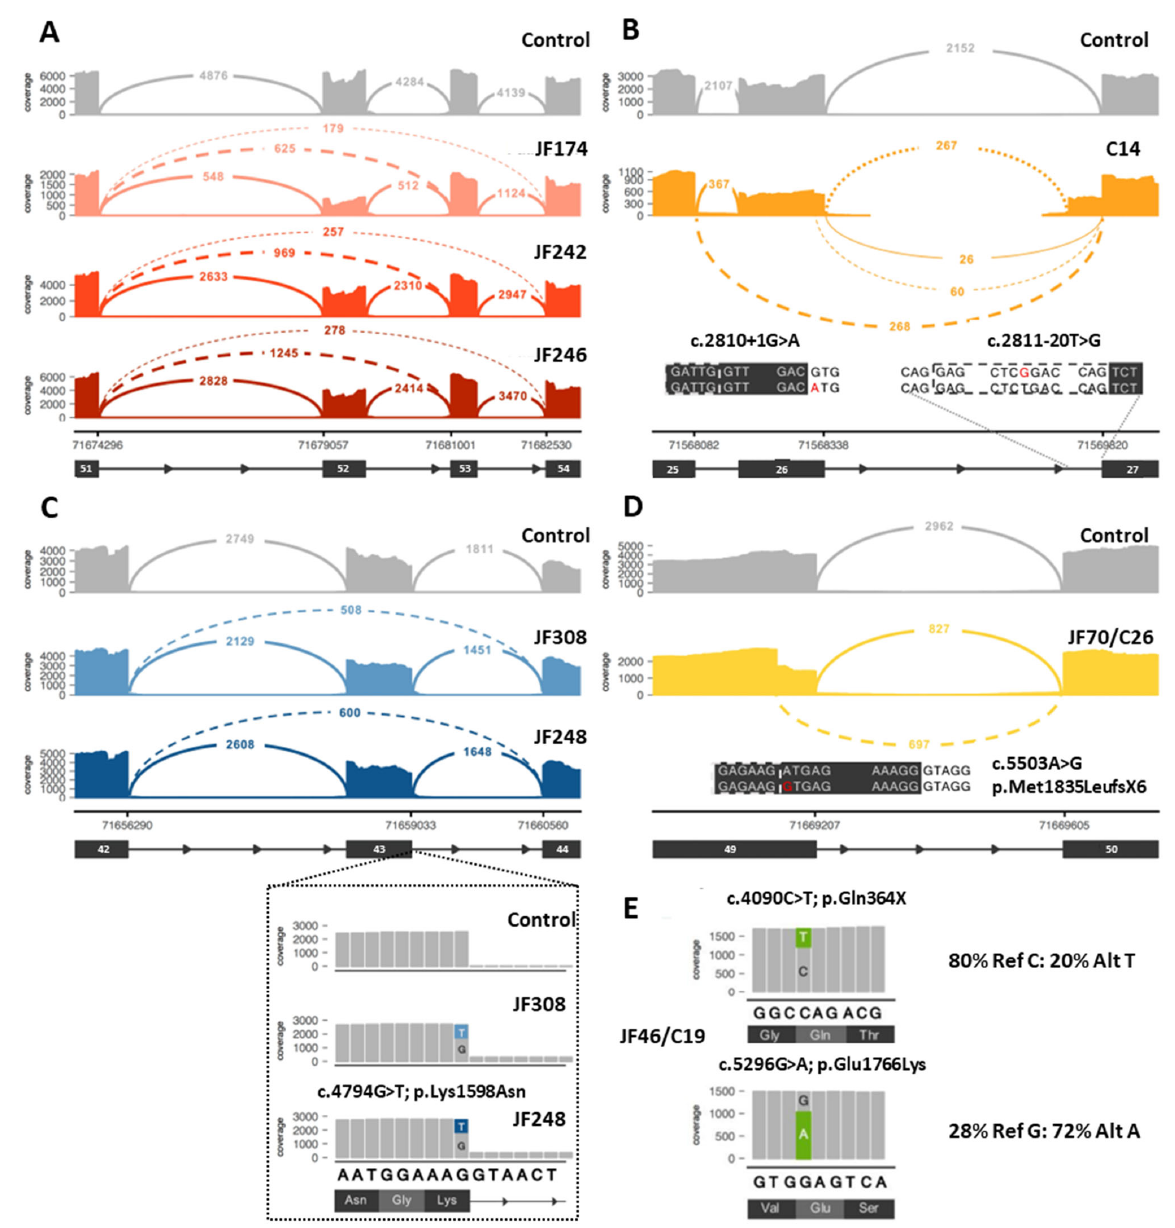
Figure 3. Examples of data that can be obtained from RNA ‐ Seq analysis to aid in the diagnosis of dysferlinopathy. ( A ) Example of identification of exonic deletion: Sashimi plot of the exon skipping events seen in three patients (JF174, JF242, JF246). Subsequent genome sequencing (GS) identified the cause of the 2 different splicing events as a gross deletion encompassing exon 52. ( B ) Example of aberrant splicing events caused by intronic variants: RNA ‐ Seq of C14 identified 2 different aber ‐ rant splicing events involving exon 26 caused by the destruction of the splice donor site by the c.2810+1G>A variant (left inset, red A indicates mutant variant) on one allele and the exon 27 exten ‐ sion caused by a novel branch point variant c.2811 ‐ 20T>G (right inset, red G indicates mutant vari ‐ ant) on the other allele. ( C ) Example of leaky aberrant splicing event. Upper: Sashimi plot showing exon skipping caused by a leaky splice variant (c.4794G>T) at the end of exon 43 in JF308 and JF248. Inset: variant expression in a minority of reads (15–18%), which show a normal splice pattern but the presence of the missense variant (c.4794G>T; p.Lys1598Asn). ( D ) Example of missense variant acting as a splice altering variant: Sashimi plot of cryptic splice site variant c.5503A>G (inset, red G indicates mutant variant) in JF70/C26 that leads to a premature stop codon (p.Met1835LeufsX6) in